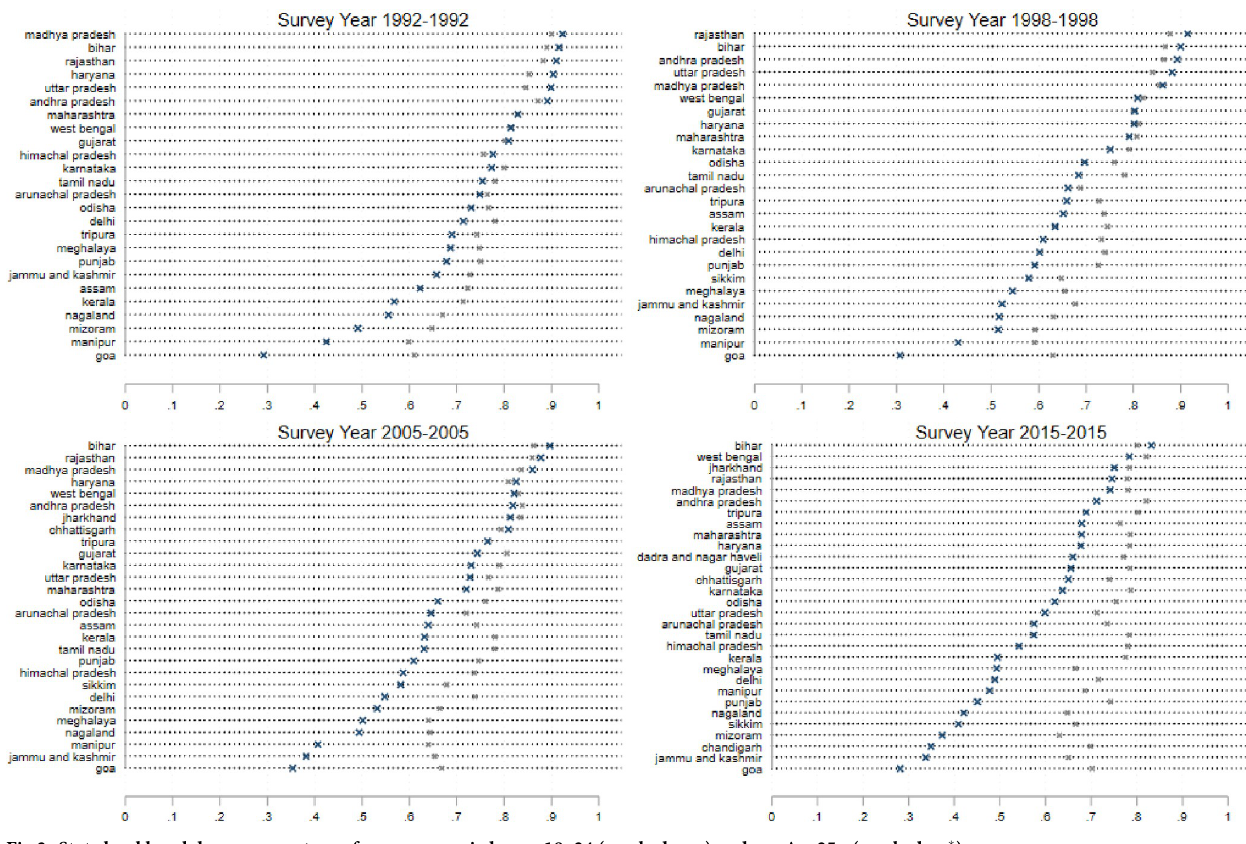
Fig 2. State level breakdown; percentage of women married, ages 18–24 (marked as × ) and age Age25+ (marked as � ).